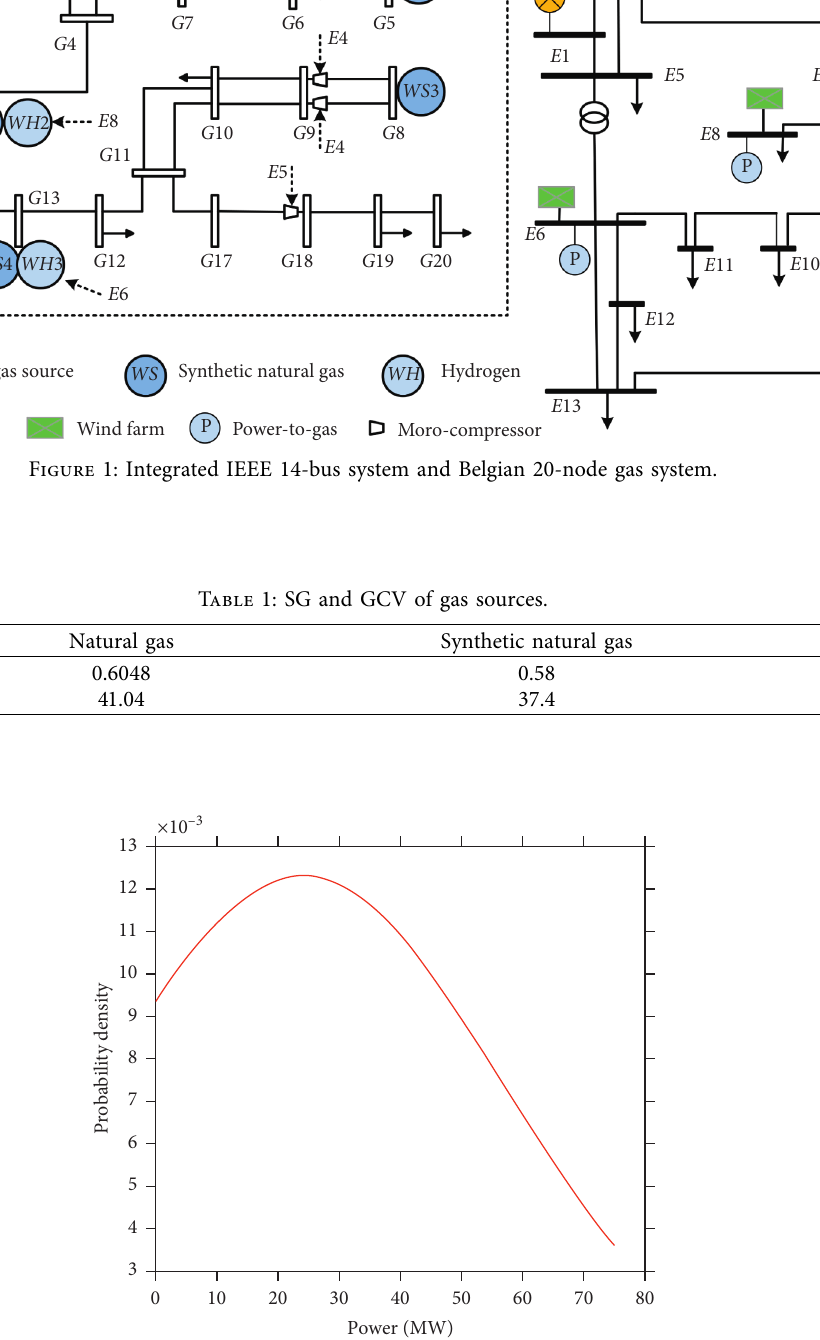
Figure 2: Probability density function of wind photovoltaic power